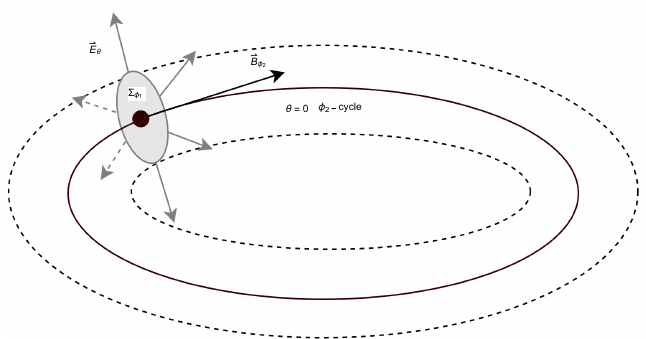
Figure 3 . The bound-state is made of a pair of two-dimensional components carrying Dyonic flux localized at the fixed-point of the rotational U(1) action. They arise due, in part, to the rotation of (3.8). Flatness condition away from the fixed loci of the rotation implies the absence of isolated electric and magnetic charge. The time cycle is not shown in this